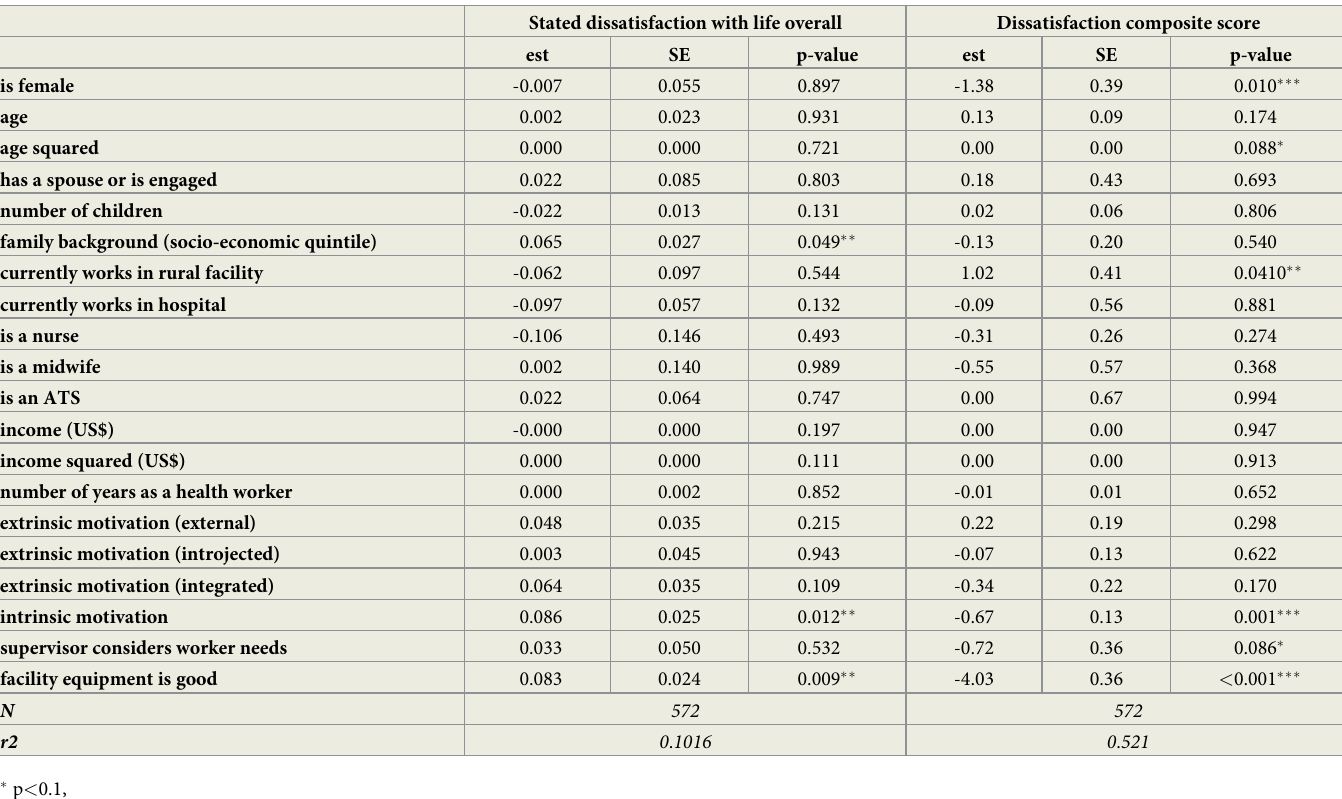
Table 3. Multiple regression model for predicting satisfaction composite score and overall satisfaction with